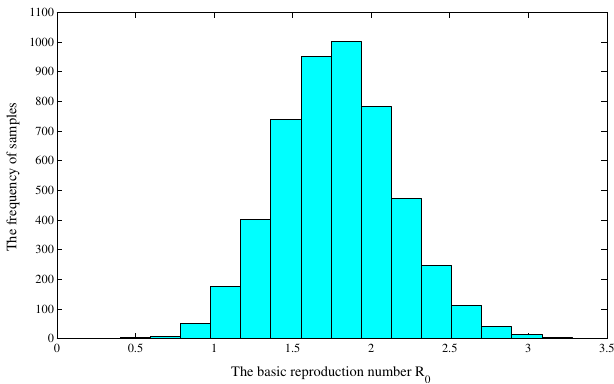
Figure 6. The numerical distribution of the basic reproduction number R 0 .